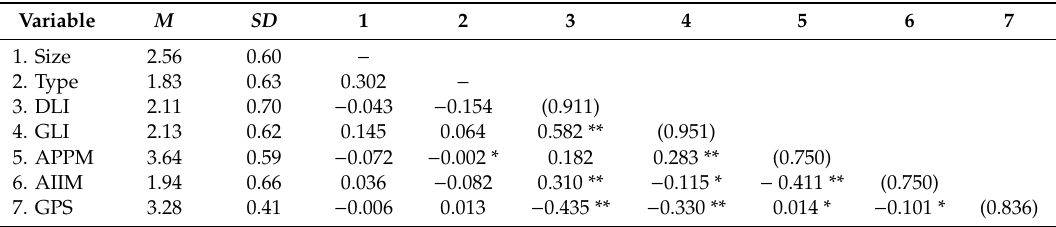
Table 1. Descriptive statistics of variables ( N =